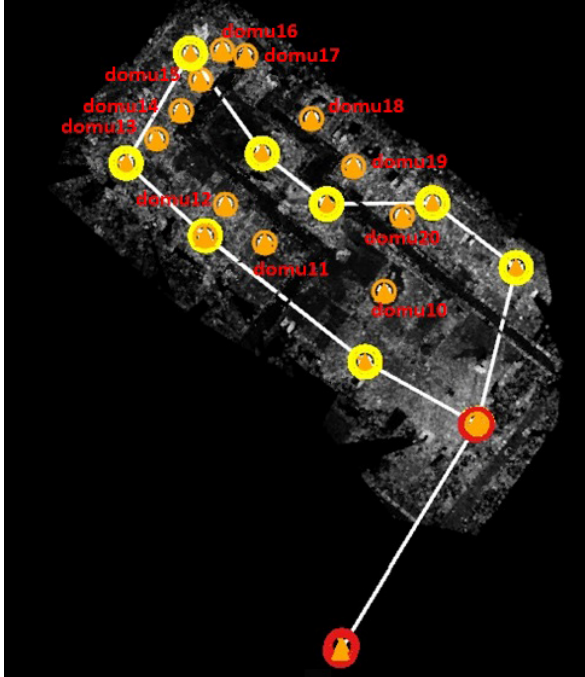
Figure 6. Traverse path of the first nine scan points (yellow circle) and the eleven “single scans” (orange circle).